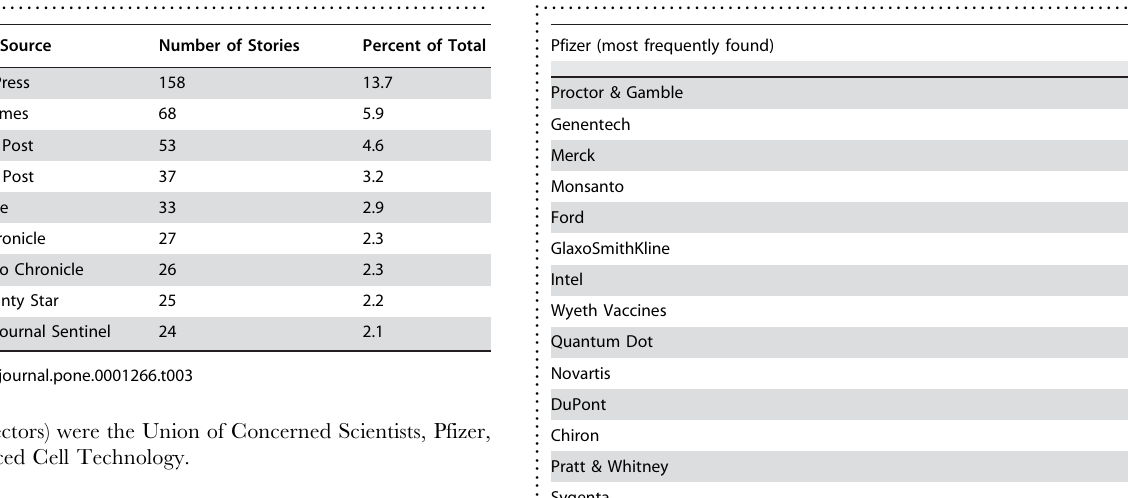
Table 3. Top sources of science news stories (those above 2%